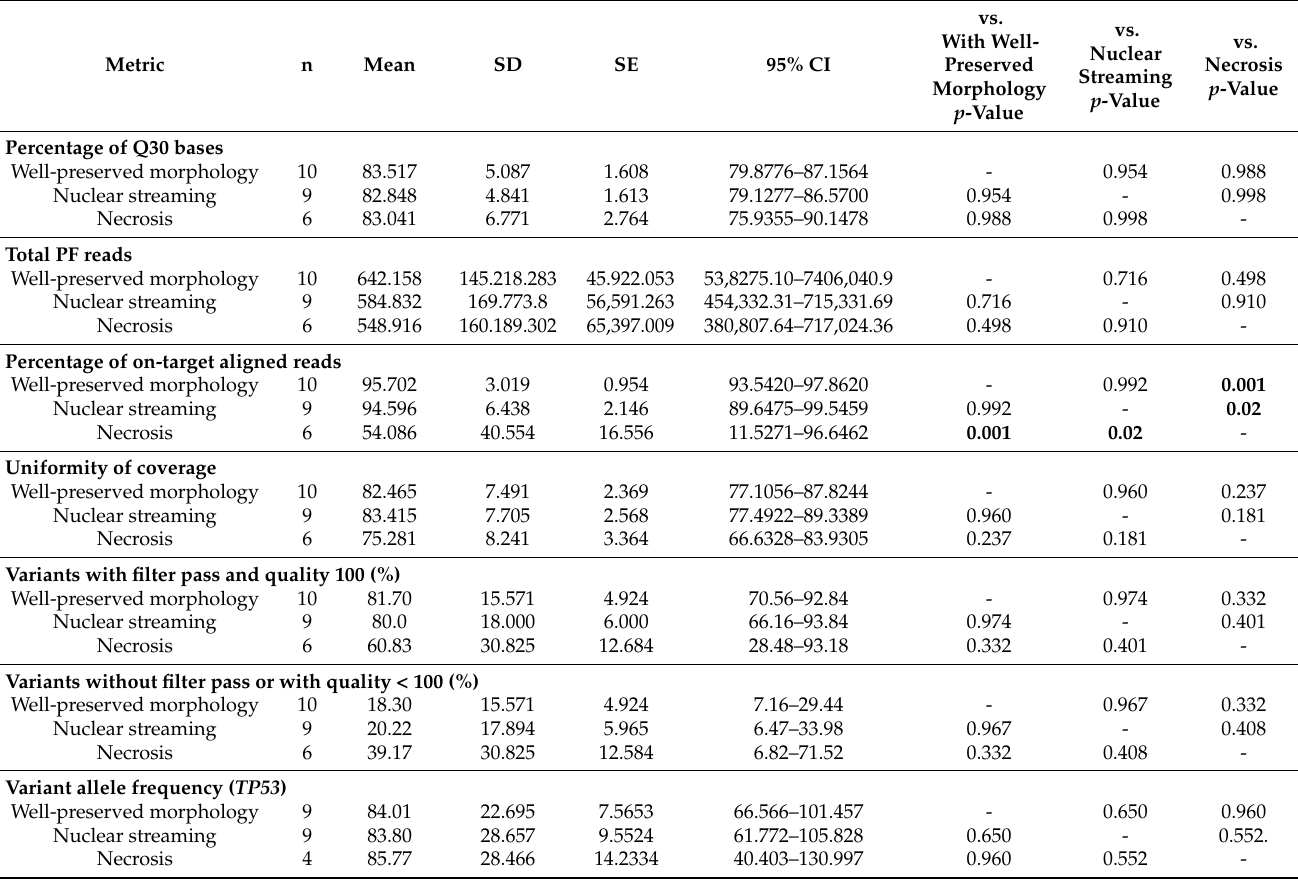
Table 4. Comparison of features between materials with well-preserved morphology, with nuclear streaming, and with